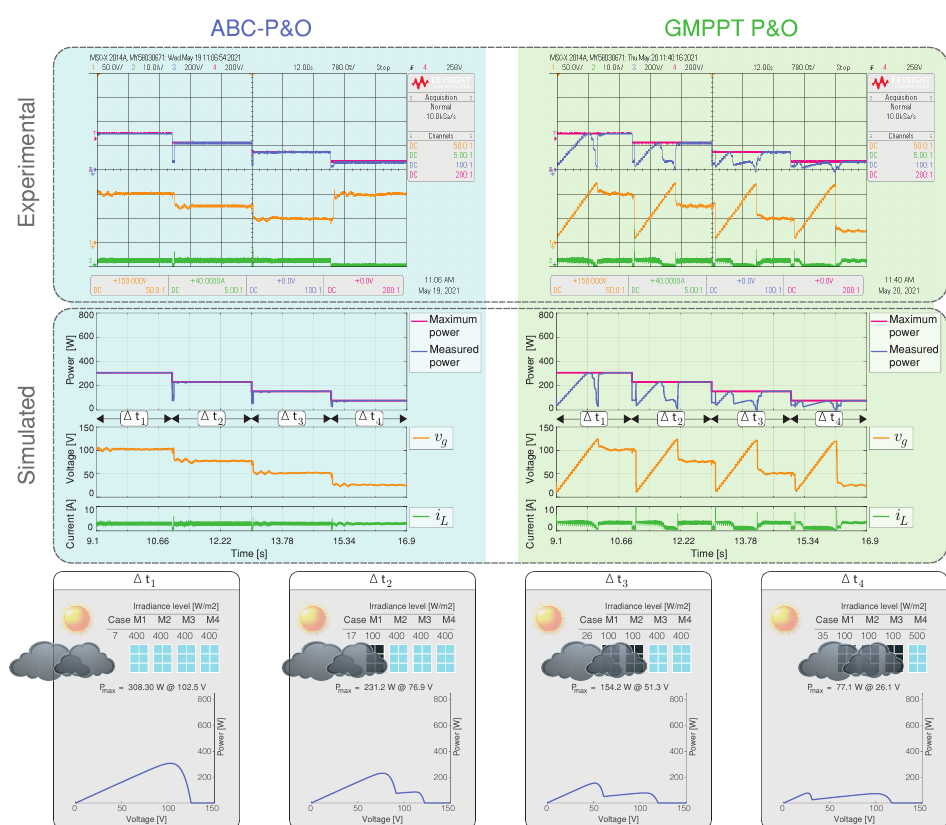
Figure 15. Simulated and experimental dynamic behavior of the MPPT algorithms for Scenario 5 with an output voltage V o = 160 V. The proposed MPPT algorithm (right) is compared with the GMPPT P&O algorithm (right). CH1: v g (50 V/div), CH2: i L (10 A/div), CH3: maximum power (200 W/div), CH4: measured power (200 W/div), and a time base of 780 ms. RE MAE